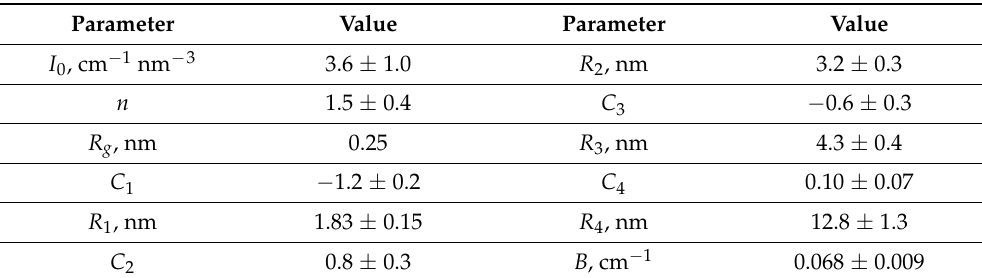
Table 2. Fitting parameters for Small-angle neutron scattering (SANS) on an Aquivion ® -type mem- brane without detonation nanodiamonds (DND), using Equation (2). Parameter Value